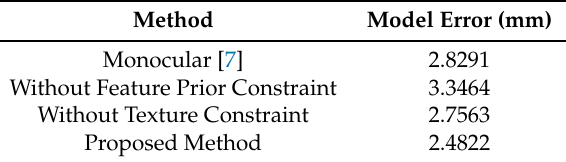
Figure 7. The vertex error distribution of all vertexes of ESRC dataset using different methods. The horizontal axis is the vertex error whose unit is millimeter (mm), vertical axis is the percentage of vertexes under a error threshold. For example, (4.4, 0.02) means that the percentage of vertexes with error 4.4 mm is nearly 2%. Color numbers are the model error. Table 1. The model error over all mesh vertices (nearly 400,000 vertices) for all meshes in the ESRC image datasets.